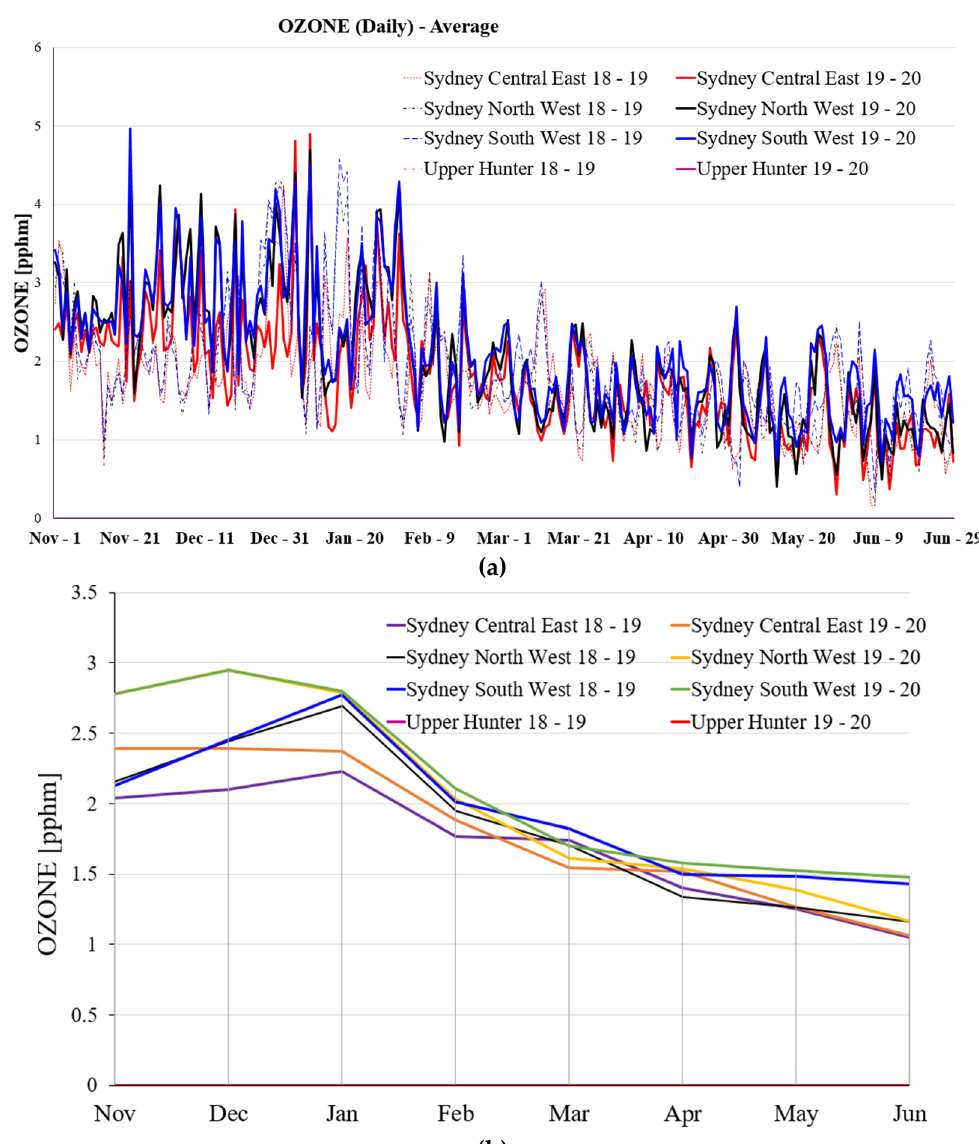
Figure 8. The average Ozone [pphm] in Sydney Central East, North West, South West, and Upper Hunter region for a period of eight months during 2018–2019 and 2019–2020, ( a ) daily average Ozone, and ( b ) monthly average Ozone.